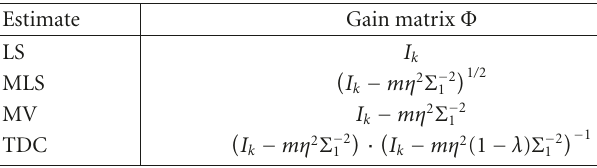
Table 1: Overview of some important gain matrix Φ in the SVD- based methods for the white noise